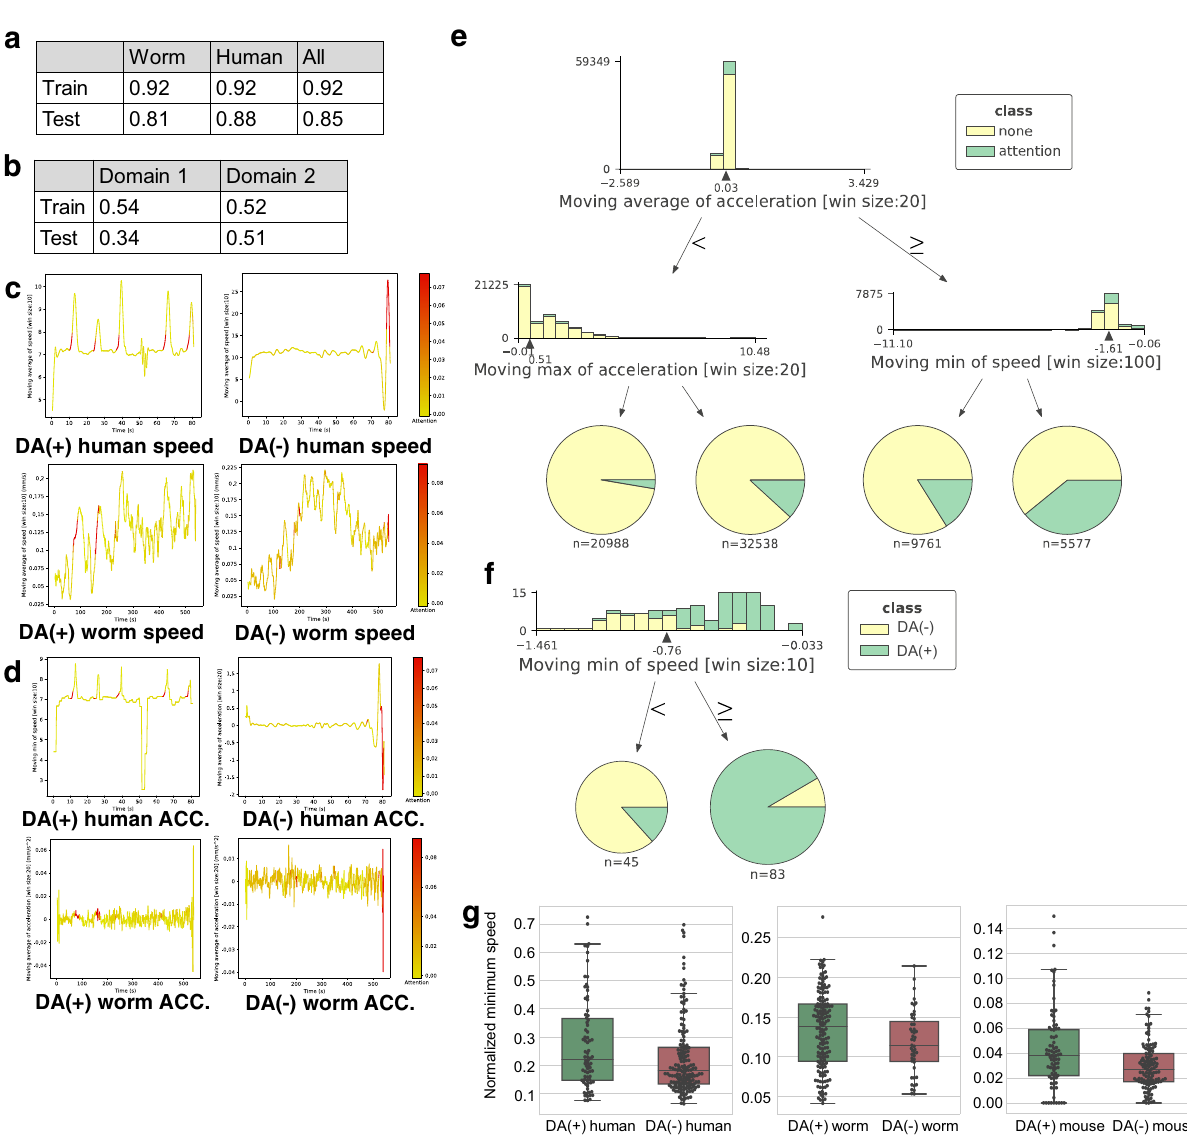
Fig. 3 Analysis of DA( + )/DA( − ) humans and worms (DA: dopamine). a Classi fi cation accuracies of our network for DA( + )/DA( − ) classes. b Classi fi cation accuracies of our network for the 1st and 2nd domain estimates; see Supplementary Information for the detailed results of the domain estimates. c Example time-series of the speed of DA( + )/DA( − ) humans and worms highlighted by our network. d Example time-series of acceleration of DA( + )/DA( − ) humans and worms highlighted by our network. e A decision tree for explaining the meaning of attention. f A decision tree for explaining classi fi cation. g Distributions of minimum speed within a time window when the average acceleration is high for humans and worms (see Supplementary Information for details); signi fi cant differences between DA( + ) and DA( − ) for both humans and worms are observed (worm by the Brunner – Munzel test: p = 0.03; w = 2.26; df = 101.91; effectsize = 0.60; n = 162 from DA( + ) worms; n = 47 from DA( − ) worms; human by the Welch ’ s t -test: p = 0.02; t = − 2.35; df = 126.89; effectsize(r) = − 0.34; n = 78 from DA( + ) humans; n = 163 from DA( − ) humans); a signi fi cant difference between DA( + ) and DA( − ) for the mice is also observed by the Welch ’ s t -test ( p = 0, 01; t = 2.57; df = 131.63; effectsize(r) = 0.38); n = 88 10 min trajectories from DA( + ) mice; n = 113 10 min trajectories from DA(-) mice; the p -value is two sided. The box plot shows the 25 – 75% quartile, with an embedded bar representing the median and the lower/upper whiskers show Q1-1.5*IQR and Q3 + 1.5*IQR, respectively, where IQR is the interquartile range, Q1 is 25% quartile, and Q3 is 75%